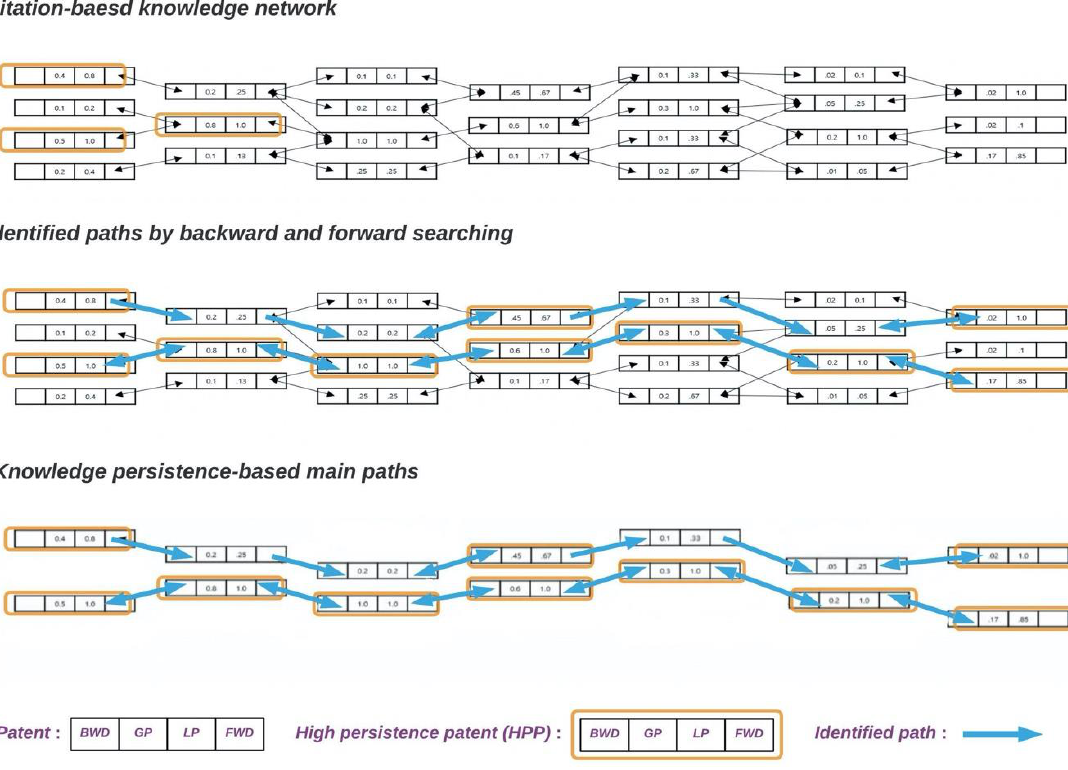
Figure 1. Backward and forward searching, from